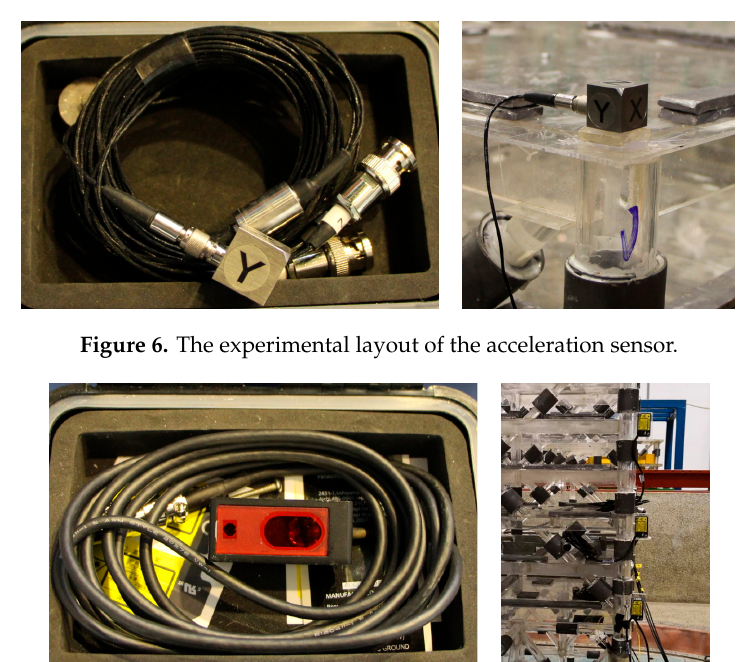
Figure 5. The National Instruments (NI) data acquisition instrument used in this experiment.